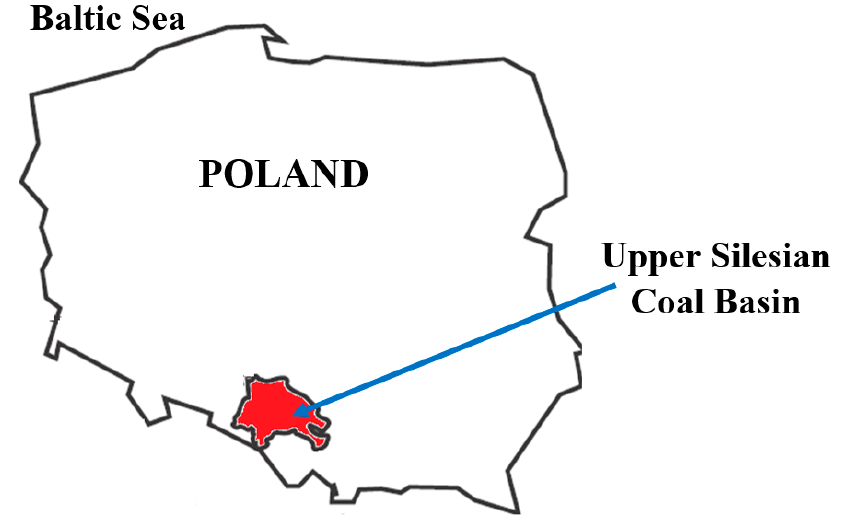
Figure 2. Location of the Upper Silesian Coal Basin in Poland.